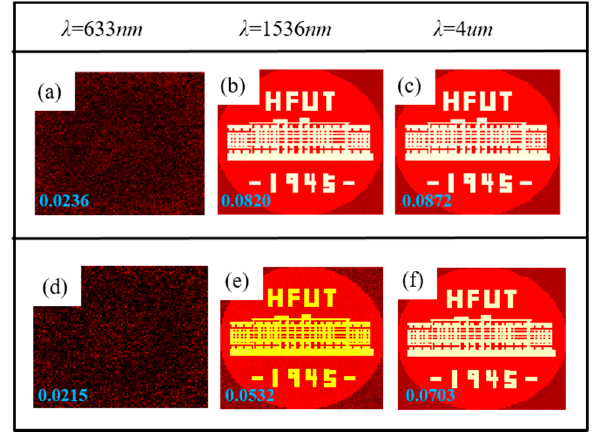
Figure 9. PR imaging effect of different wavelengths and different weather conditions. Clear ( a ),( b ),( c ), cloudy ( d ),( e ),( f ) at wavelength 632nm,1536nm,4 μ m, respectively. The blue numbers indicate the contrasts of the images.